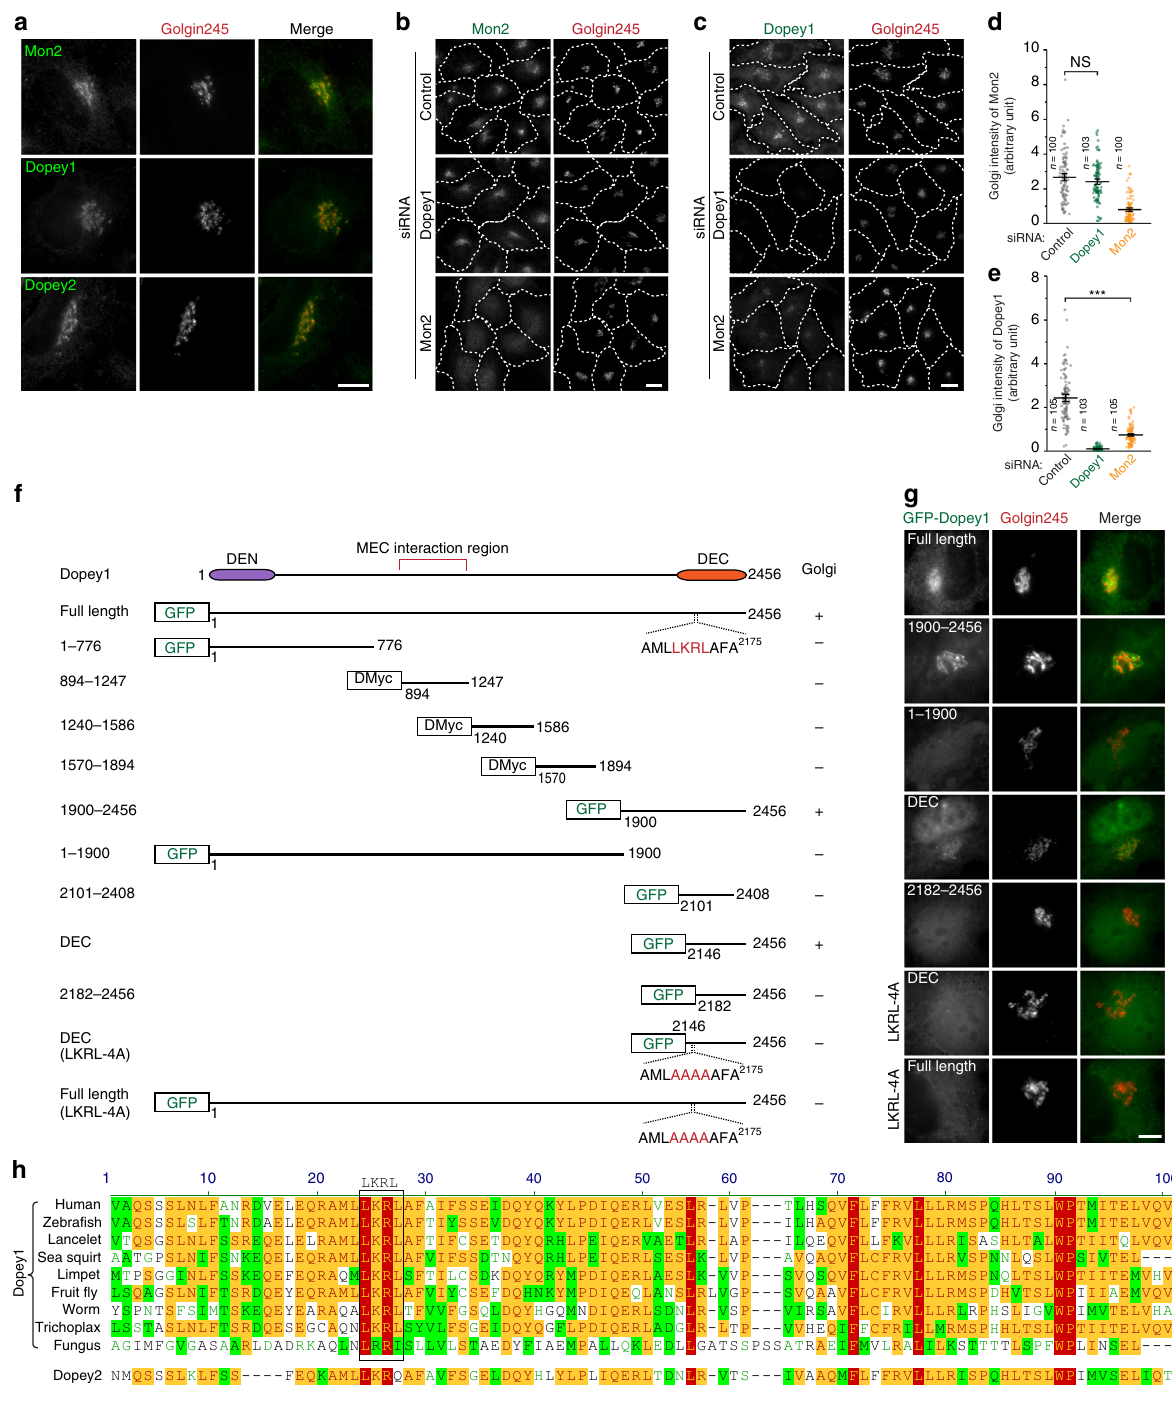
Fig. 2 The Golgi localization of Dopey1. a Endogenous Dopey1 and Mon2 localize to the Golgi. Cells were subjected to immuno fl uorescence to co-stain Mon2, Dopey1, or Dopey2 together with Golgin245 (a Golgi marker). b – e The Golgi localization of endogenous Dopey1 requires Mon2. Cells were subjected to knockdown by indicated siRNAs followed by immuno fl uorescence to reveal indicated proteins in ( b , c ). Cell contours are marked by white dotted lines. The Golgi fl uorescence intensity of Mon2 ( d ) and Dopey1 ( e ) per cell was subsequently quanti fi ed. n , the number of cells analyzed; error bar, mean ± s.e.m. P values are from t test (unpaired and two-tailed). N.S., not signi fi cant; ***, P ≤ 0.0005. f , g DEC is necessary and suf fi cient for the Golgi localization of Dopey1. Schematic diagrams of Dopey1 truncations and mutants are shown in ( f ). The Golgi localization is scored based on fl uorescence staining experiment in ( g ), in which cells expressing selected Dopey1 truncations and mutants were stained for Golgin245. h Multiple alignment of metazoan protein sequences of DEC. Uniprot IDs used are B2RWN9 (human), F1R226 (zebra fi sh), C3ZLF8 (lancelet), F7BCQ8 (sea squirt), V3ZCY9 (limpet), A1ZBE8 (fruit fl y), Q9XW10 (worm), B3S9K0 (trichoplax), and Q9Y7B3 (fungus). The corresponding region of human Dopey2 (Uniprot ID: Q9Y3R5) is also included below. Scale bar, 10 µ m. All cells are HeLa cells. Source data are provided as a Source Data fi